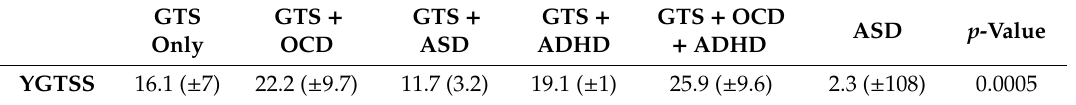
Table 2. Comparison between mean YGTSS values in each sub-phenotype and statistical significance.